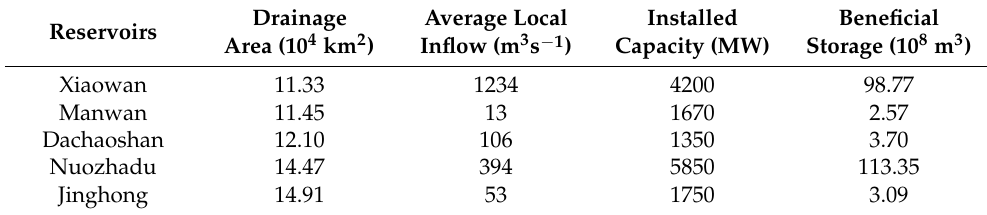
Figure 3. Structure of the studied cascaded hydropower reservoirs. Table 1. Characters of hydropower reservoirs on main stream of Lancang River in Yunnan Province.